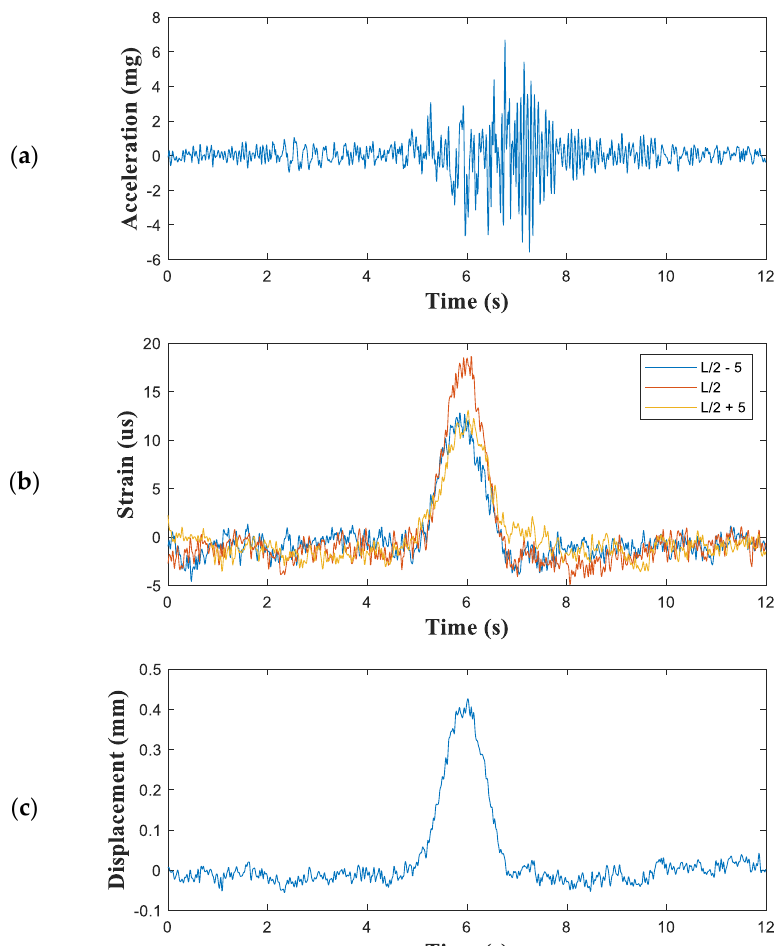
Figure 15. Measured structural responses and estimated displacements of the Geumgok Bridge: ( a ) measured vertical acceleration; ( b ) three-channel strains; and ( c ) estimated displacements.